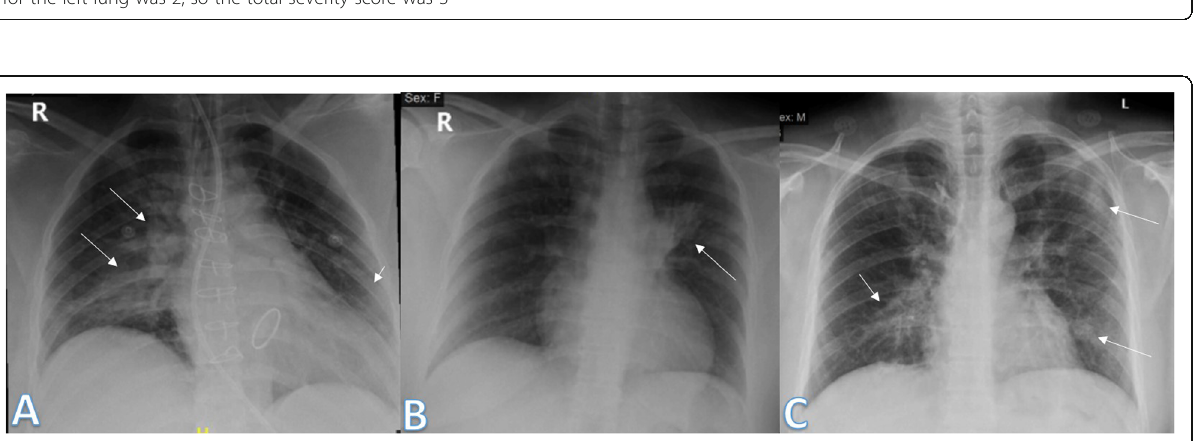
Fig. 2 Three different patients with positive COVID-19. a 39-year female was complaining of SOB with tachypnea, fever, and cough. She had previous open cardiac surgery with valve replacement. She was intubated due to hypoxemia. Chest X-ray showed right perihilar air space consolidation opacity extending to the right paracardiac region (long arrows). Another left lower zonal air space consolidation opacity was seen (short arrow); the severity score was 2 for the right lung and 1 for the left lung, so TSS was 3. b 44-year female was complaining of fever. Initial chest X-ray showed left perihilar air space consolidation opacity (arrow). The total severity score was 1. c 35-year male was complaining of cough and fever. Initial chest X-ray showed right perihilar air space consolidation opacity (short arrow). Other left lower zonal air space consolidation opacities are seen (long arrows) with reticular thickening; the severity score was 1 for each lung, so TSS was